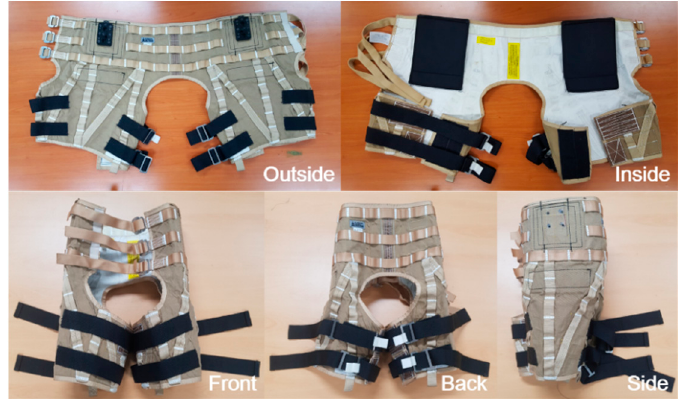
Figure 1. Developed novel harnesses.